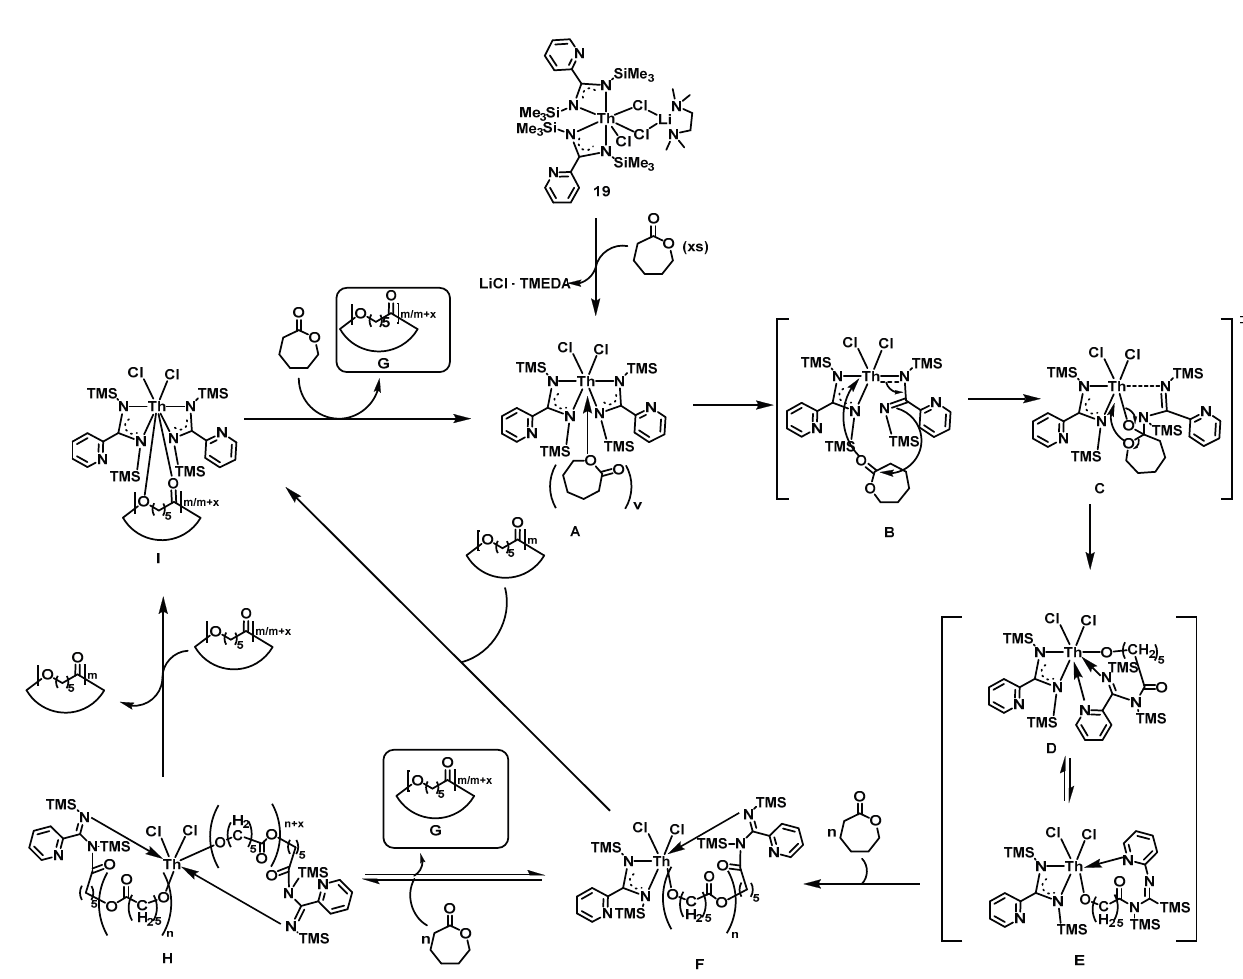
activity in the order 23 > 24 > 25 > 21 > 22 [91]. Hence, the thorium complexes 23 – 25 are more active more active than the analogous compounds with a pyridyl moiety at the ipso -position ( 22 and 25 ). Furthermore, complexes 21 and 23 with a shorter carbon linker chain ( n = 2) display a higher catalytic activity than their analogues 23 , 24 – 25 with a longer linker chain ( n = 3), suggesting an increase of the catalytic activity with increasing electron density of the metal